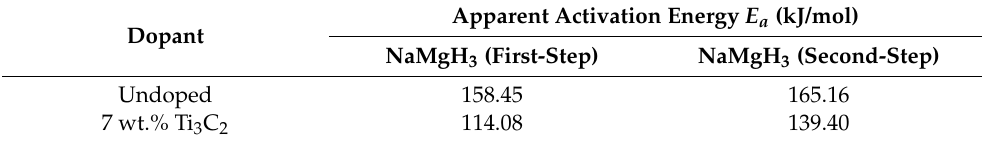
Figure 4. DSC curves for ( a ) pure NaMgH 3 ; ( b ) NaMgH 3 -7 wt.% Ti 3 C 2 at different heating rates; and Kissinger plots of ( c ) first- and second-step dehydrogenation of both samples. Table 1. Activation energies ( E a ) for the dehydrogenation of the NaMgH 3 sample undoped and doped with 7 wt.% Ti 3 C 2.